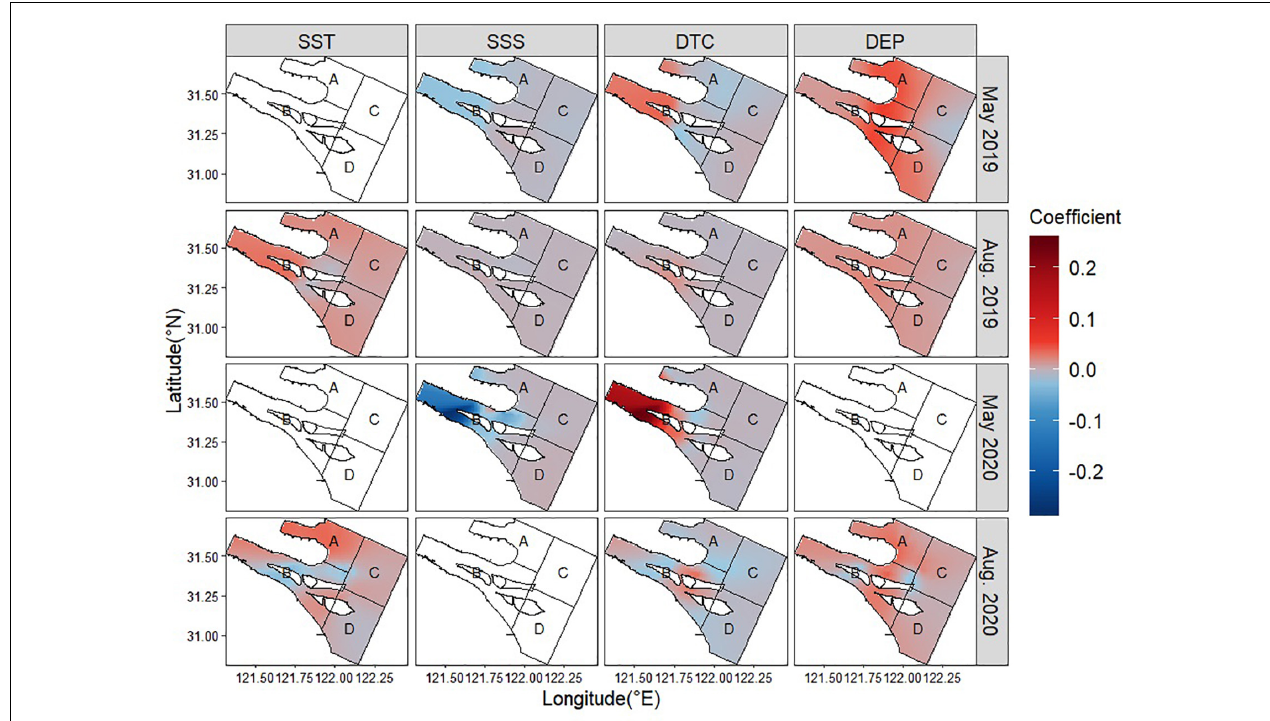
FIGURE 5 | Distribution of coefficients estimated for each cruise. The red color represents a positive relationship with the square root of egg density and the blue color represents a negative relationship with the square root of egg density. The blank figure represents independent variables that were not involved in the model.